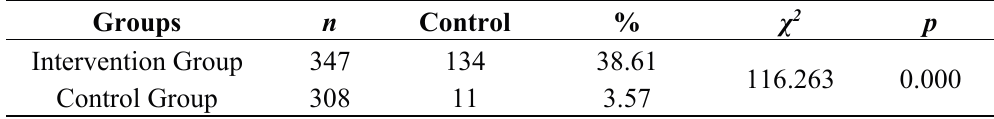
Table 3. The control rate of dyslipidemia in the intervention and control groups.